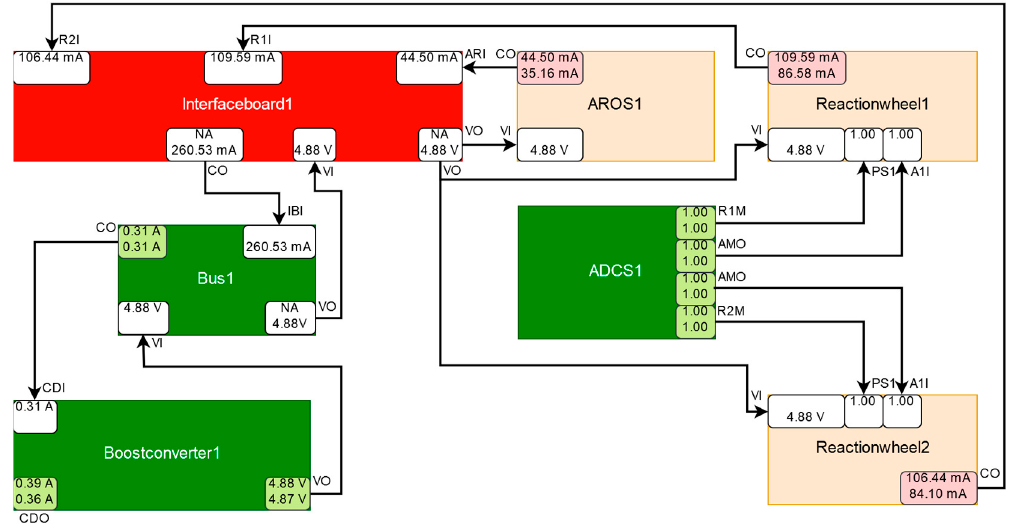
Figure 28. Simplified schematic depiction of the suspected components AROS1, Reactionwheel1, Reactionwheel2, and Interfaceboard1 and its relevant surrounding components (explanation see Figure 20). The dark red coloring of Interfaceboard1 indicates that it is part of a diagnosis with a high probability and the light red coloring of AROS1, Reactionwheel1, and Reactionwheel2 indicates that they are part of a diagnosis with a lower probability.